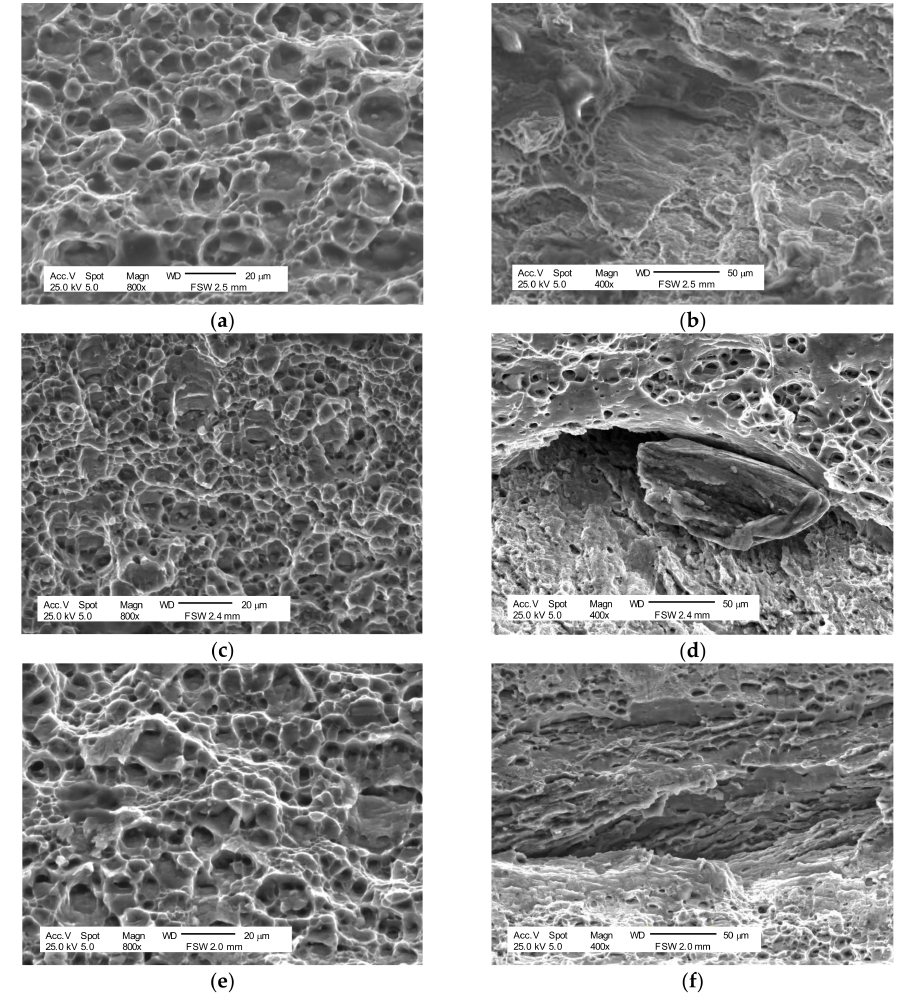
Figure 4. Scanning electron microscope fractography of the FSWed and FSWed+CRed samples deformed along the cold rolling direction: ( a ) ∆ h = 0 mm (lower magnification); ( b ) ∆ h = 0 mm (higher magnification); ( c ) ∆ h = 0.1 mm (lower magnification); ( d ) ∆ h = 0.1 mm (higher magnification);